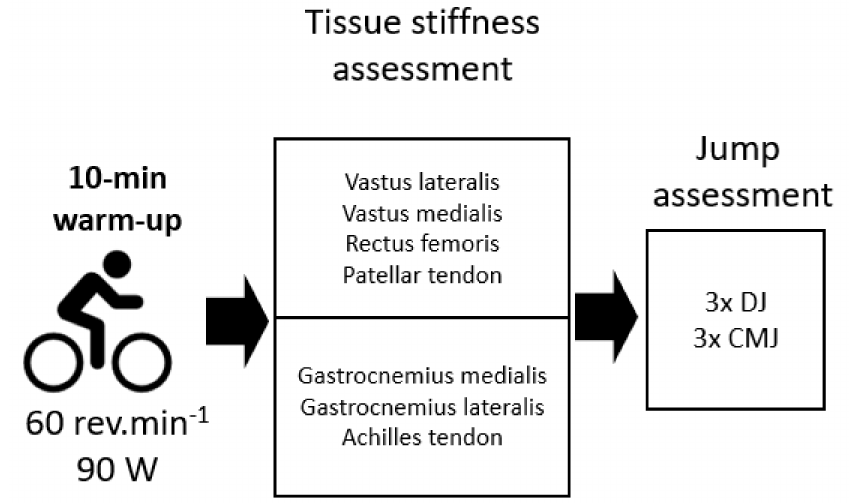
Figure 1. Schematic schedule of the study; CMJ—countermovement jump; DJ—drop